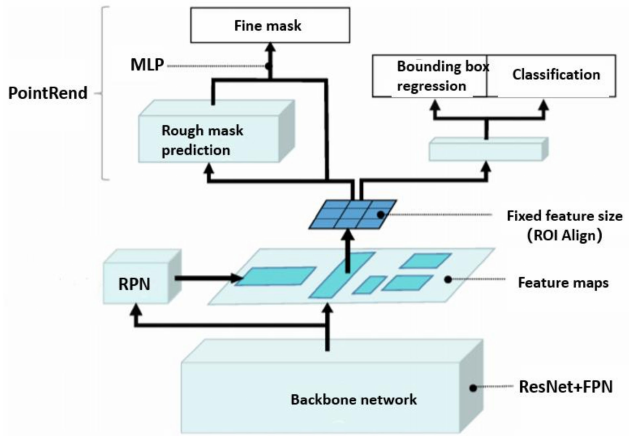
Figure 9. Optimizing the overall structure of Mask R-CNN.